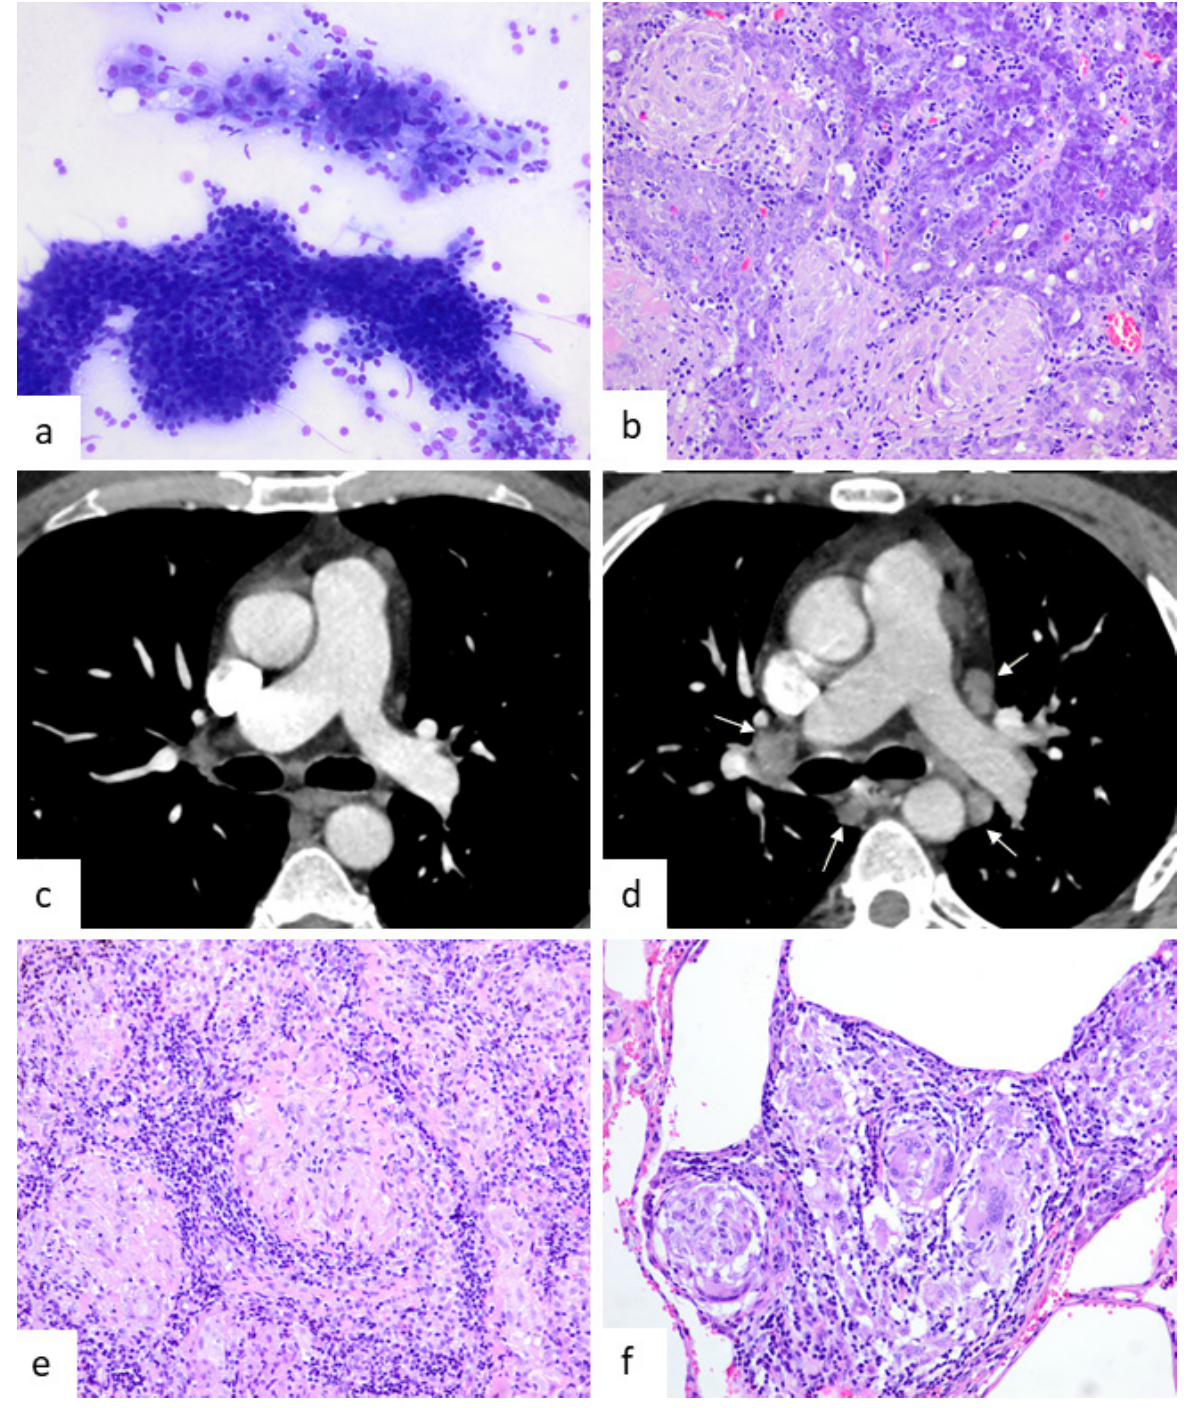
Figure 2. Images from patient 1 that motivated the study. ( a , b ) Parotid acinic cell carcinoma showing granulomas in a fine needle aspiration sample and subsequent surgical specimen (Diff-Quik, × 400, HE, × 400, respectively). ( c , d ) The first CT scan ( c ) was performed 6 months after surgery and shows no abnormalities. A second CT scan ( d ) performed 15 months after surgery shows evident mediastinal lymphadenopathies (gray arrows) that were absent in the previous one. ( e , f ) Mediastinal lymph node and lung biopsy showing numerous non-necrotizing granulomas (HE, ×